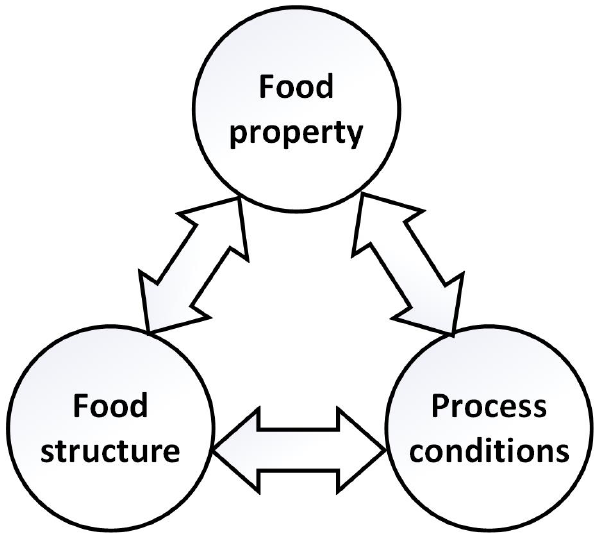
Figure 1. Relationships in process conditions, as well as food structure and property.